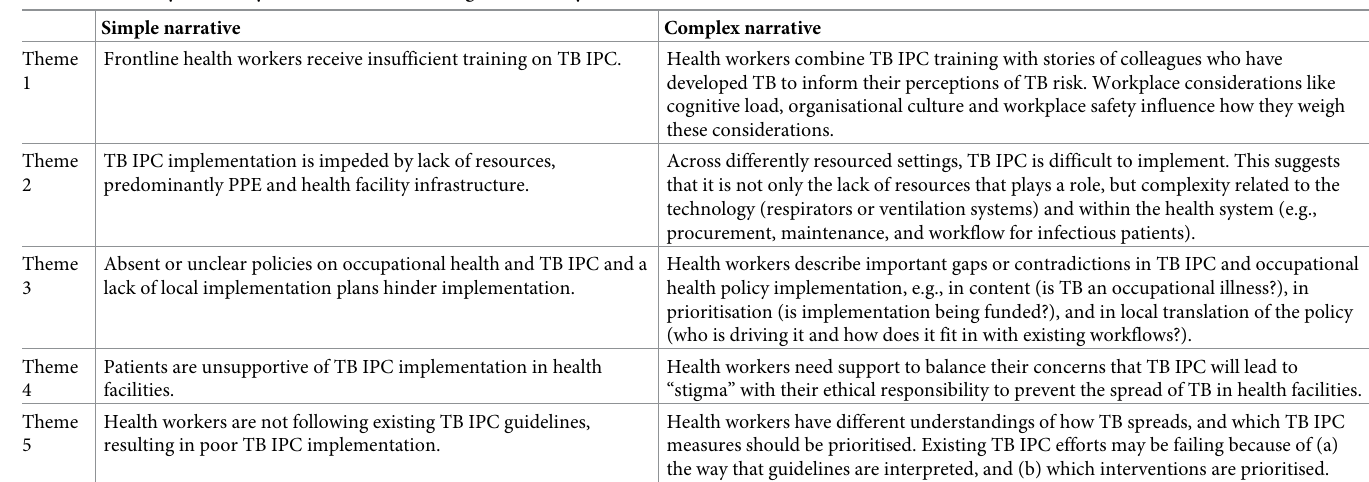
Table 1. Summary of five key themes identified through thematic